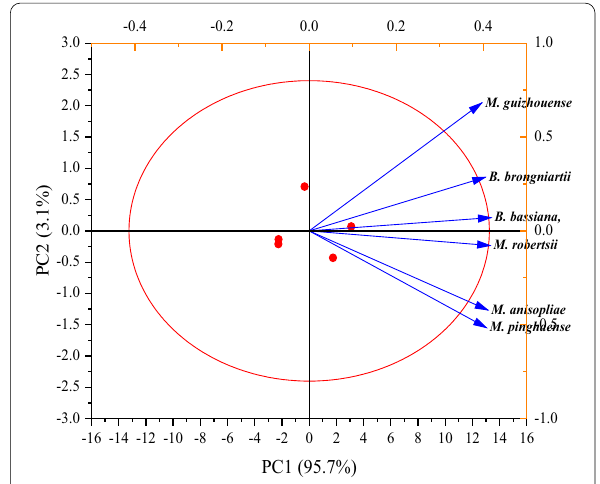
Fig. 4 Principal component analysis (PCA) obtained from the profiles of volatile compounds released by entomopathogenic fungi